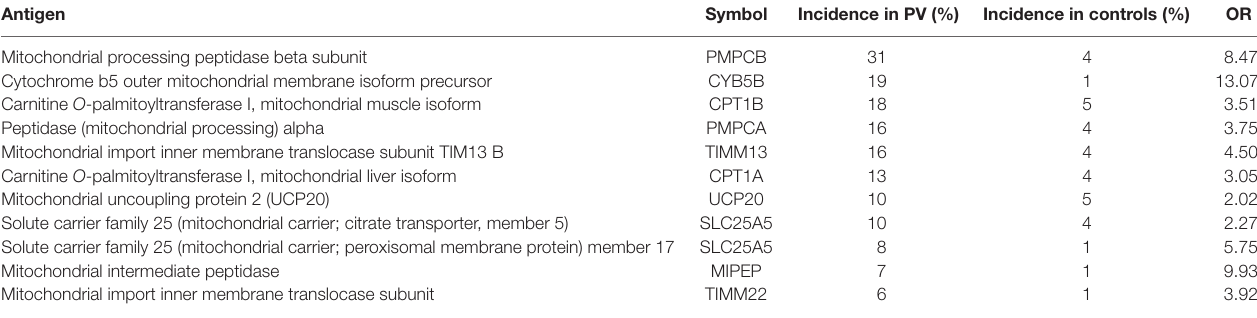
TABLe 1 | Mitochondrial autoantibodies in patients with PV with an incidence greater than 5% and OR > 2 when compared with healthy controls (10). Antigen Symbol incidence in Pv (%) incidence in controls (%)